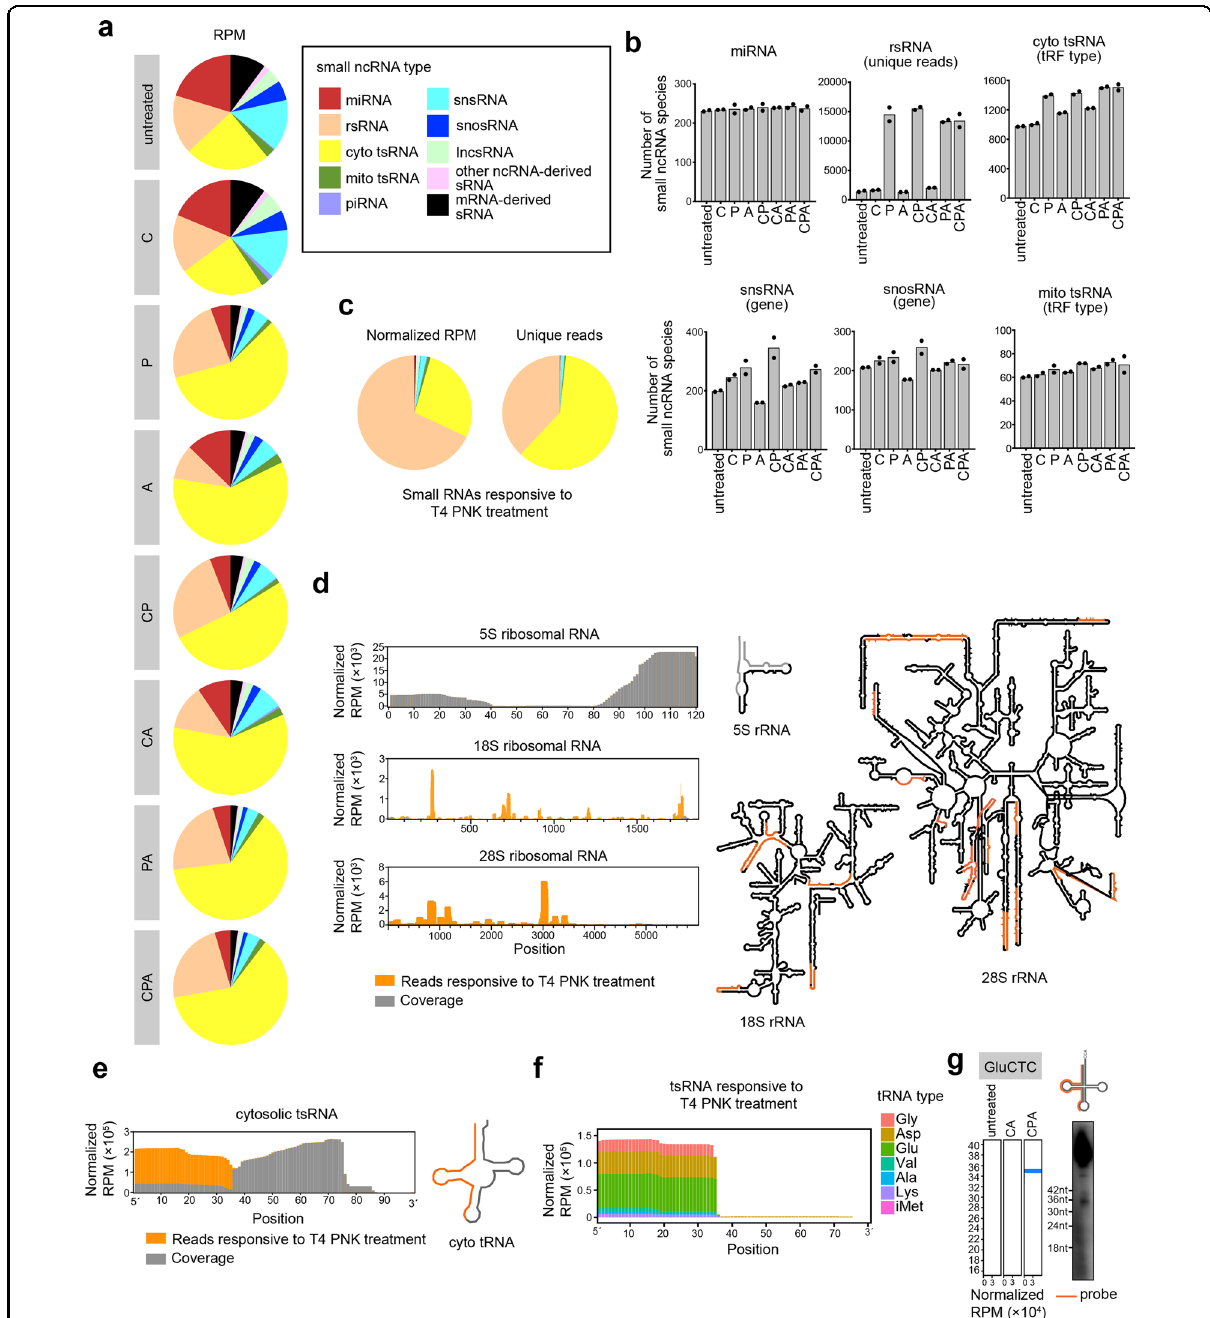
Fig. 2 CPA-seq reveals sRNAs with diverse termini. a Distribution of different types of sRNAs extracted from HEK293T cells that we process with the full CPA-seq process or with various combinations of the Cap-Clip, T4 PNK, and AlkB mix enzymes ( n = 2). b The number of sRNA species revealed with different treatments ( n = 2). c Distribution of different types of sRNAs responsive to T4 PNK treatment (unique reads that were highly detected in CPA group, but lowly detected in CA group with the fold change > 30, n = 2). d Reads of sRNA responsive to T4 PNK treatment mapping to 5S, 18S, and 28S ribosomal RNAs have been combined to show detection of rsRNAs containing diverse termini (rsRNAs with RPM > 300 are shown in the structural map). e Reads of sRNA responsive to T4 PNK treatment mapping to cytosolic tsRNAs have been combined to show detection of tsRNAs containing diverse termini. f Reads of tsRNAs responsive to T4 PNK treatment. g Northern blotting of GluCTC 5 ′ tsRNAs that are responsive to T4 PNK